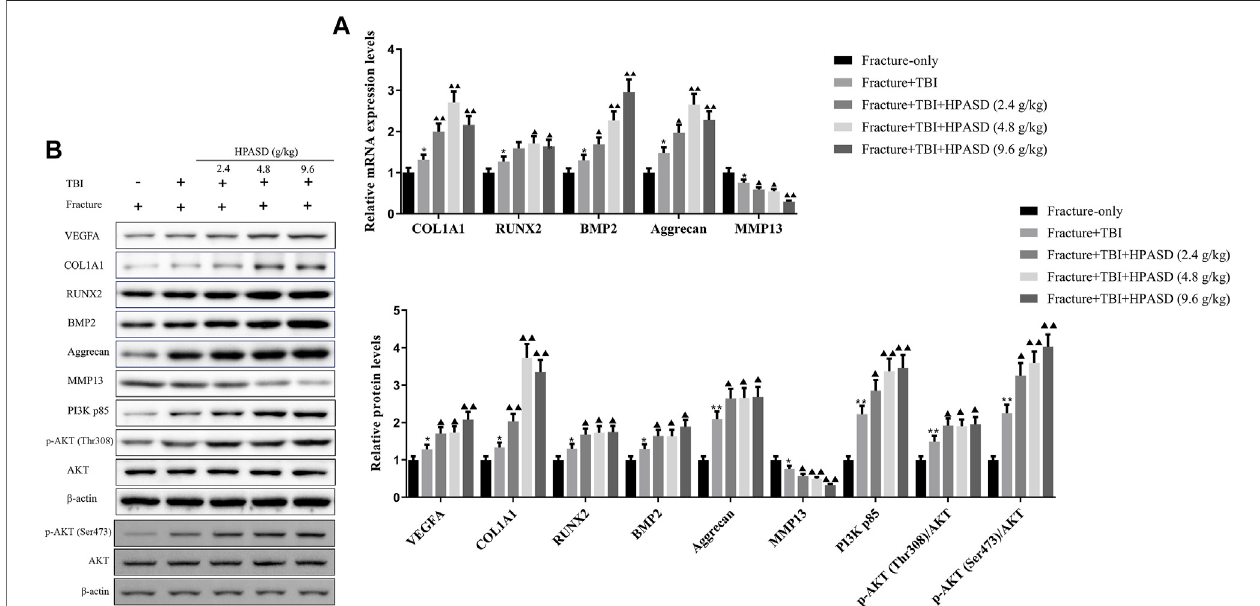
FIGURE 9 | HPASD promoted the expressions of osteogenic factors in the rat model of traumatic brain injury by activating PI3K/AKT pathway. (A) The mRNA expression levels of osteogenic factors, COL1A1, RUNX2, BMP2, Aggrecan, and in fl ammation-related factor, MMP13 were evaluated by real-time PCR (B) Representative western blots and quantitative analysis of the VEGFA, COL1A1, RUNX2, BMP2, Aggrecan, MMP13, PI3K p85, p-AKT (Thr308), p-AKT (Ser473), and AKTinthecallustissuesofTBIratsineachgroup.* p < 0.05 ,** p < 0.01 vs.Fracture-onlygroup; ▲ p < 0.05 , ▲▲ p < 0.01 vs.Fracture+TBIgroup[unpairedStudent ’ s